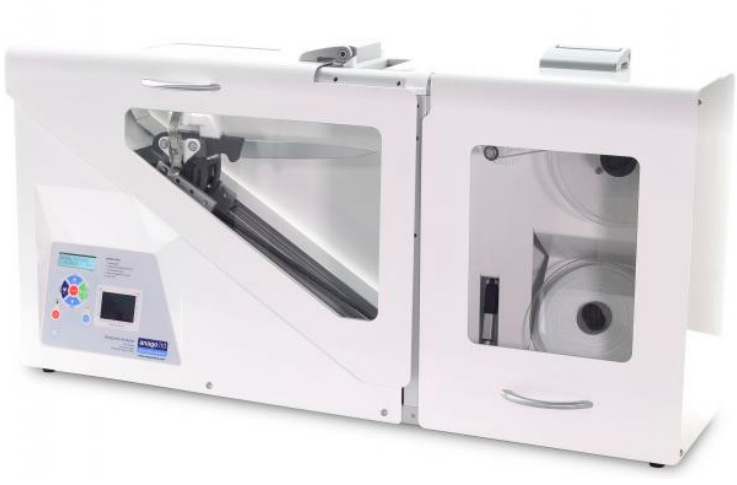
Figure 2. The ANAGO ® knife sharpness tester KST 300e.